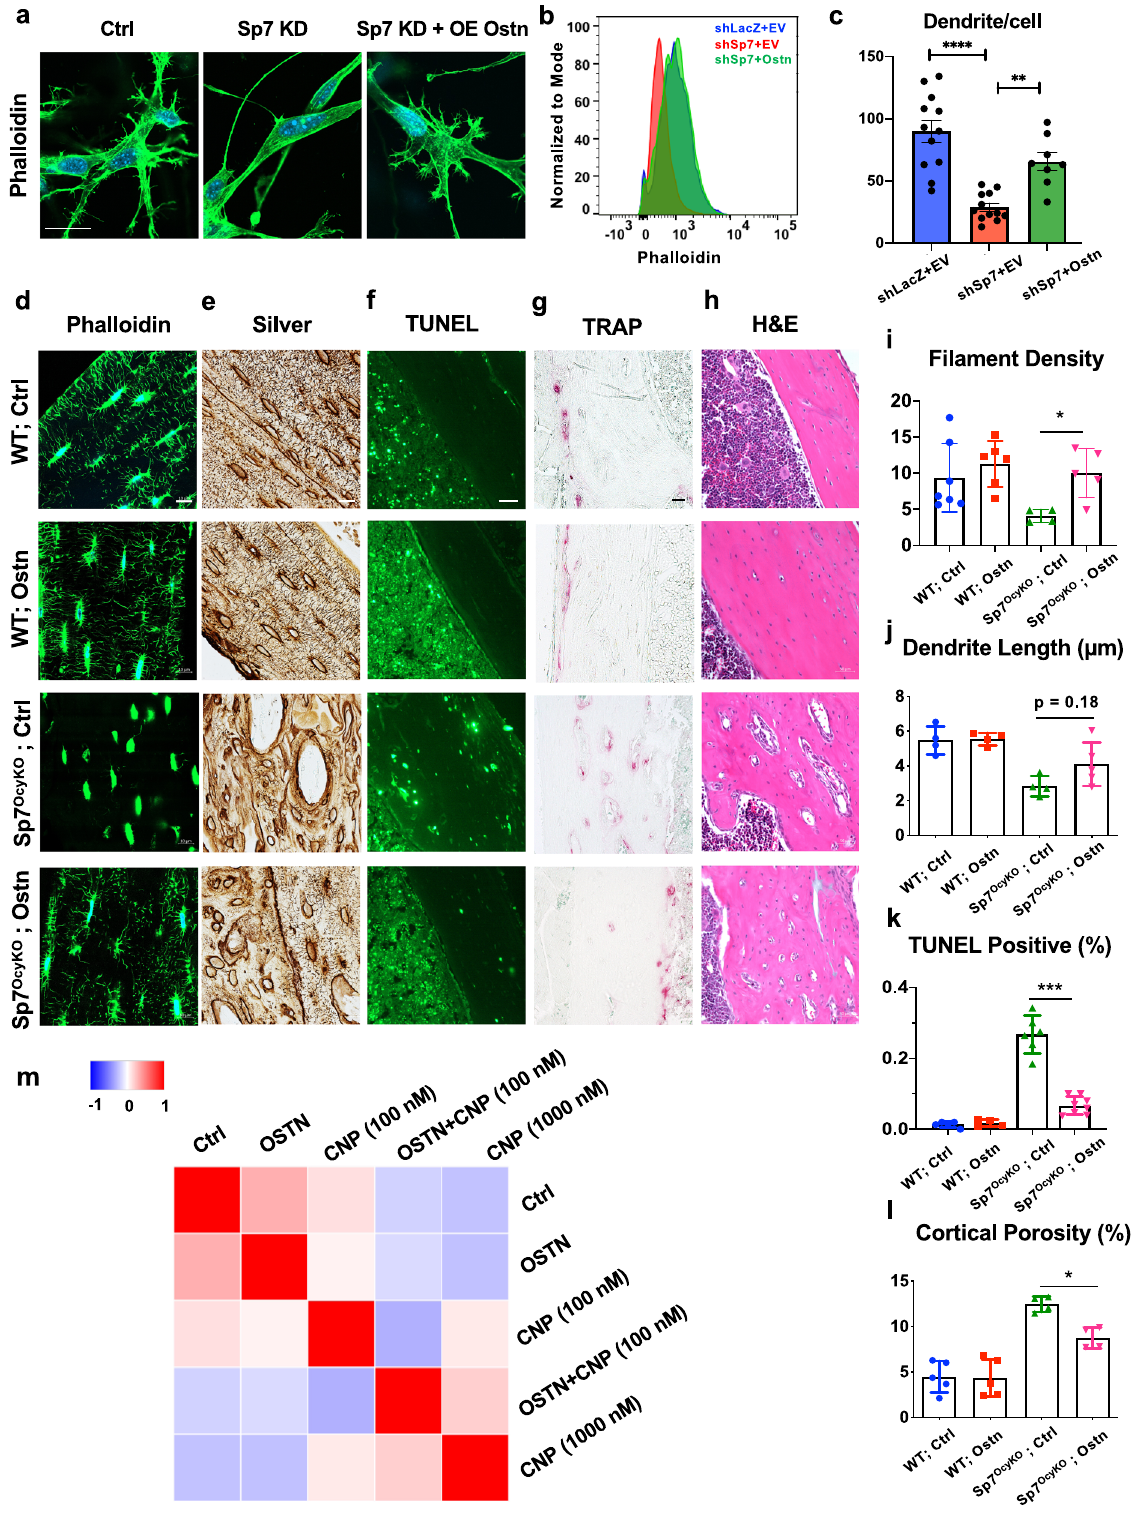
model that defects in osteocyte dendrites are the primary insult that ultimately drives the cortical bone phenotype in Sp7 OcyKO mice, we acknowledge the possibility that other molecular func- tions of Sp7 in mature osteoblasts and osteocytes may contribute. Both MC3T3-E1 (Fig. 2a) and Ocy454 (Supplemental Fig. 3a) cells grown in 3D collagen gels develop complex dendrite pro- jections in an Sp7-dependent manner. Transcriptomic analysis